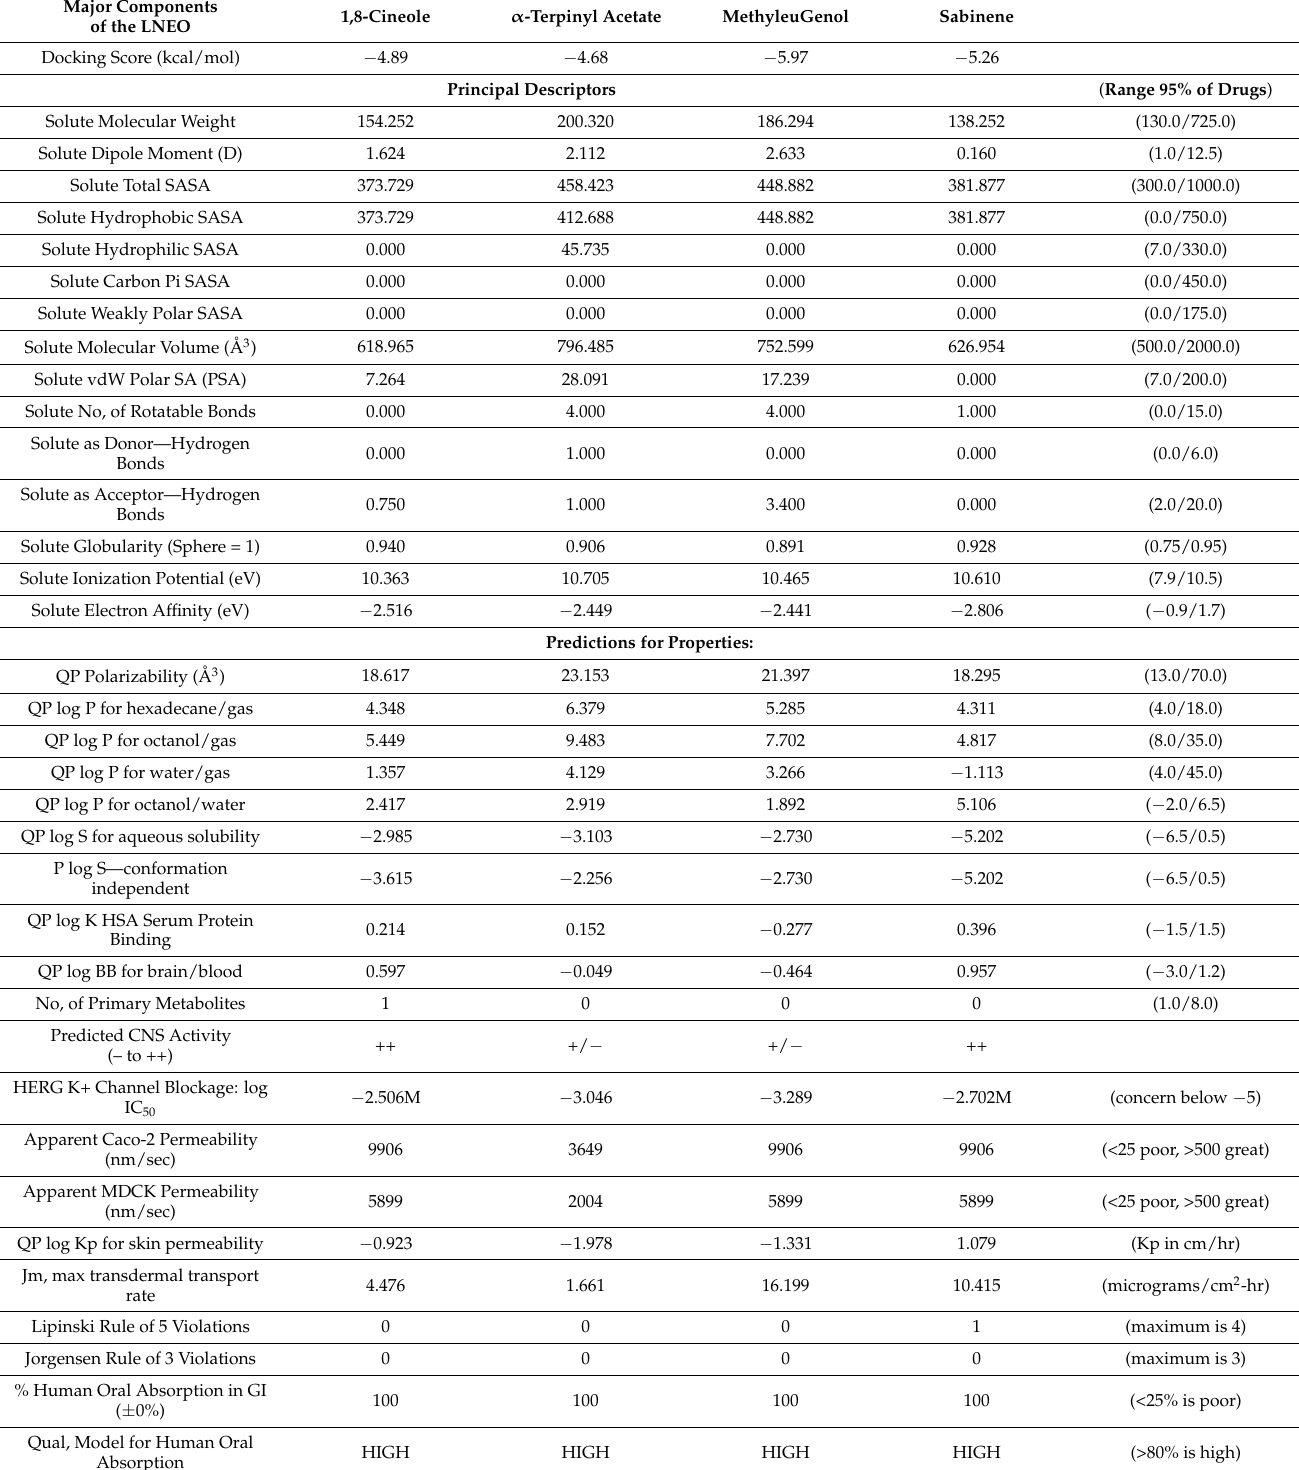
Table 3. The calculated ADME properties of the major components of the LNEO from Laurus nobilis L. docked with a dual PI3K/mTOR